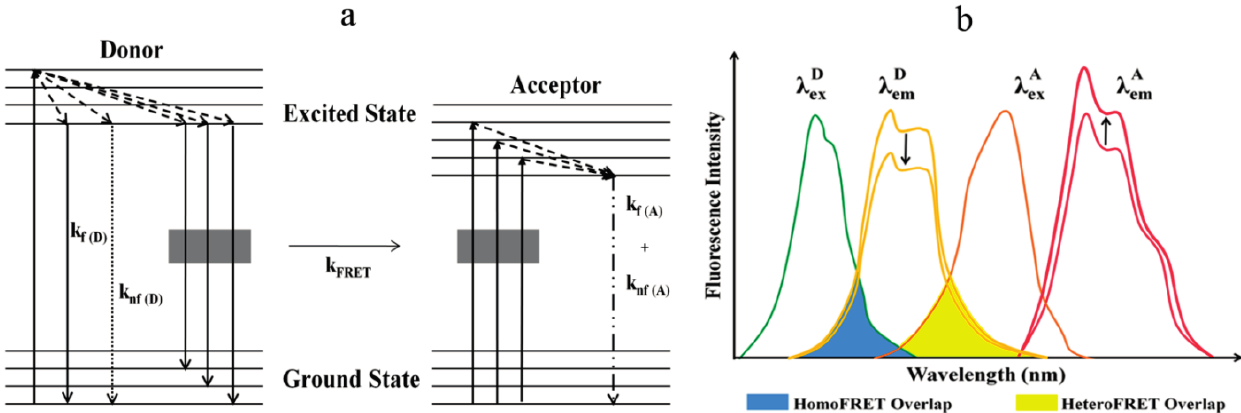
figure. The symbols “ λ (cid:2915)(cid:2934)(cid:2888) ” and “ λ (cid:2915)(cid:2923)(cid:2888) ” or “ λ (cid:2915)(cid:2934)(cid:2885) ” and “ λ (cid:2915)(cid:2923)(cid:2885) ” indicate excitation ( λ ex ) and emission spectra ( λ em ) of donor and acceptor fluorophores respectively with upper index letters denoting fluorophores. Essential spectral overlap in the case of heteroFRET (yellow) and homoFRET (blue) is also highlighted in the